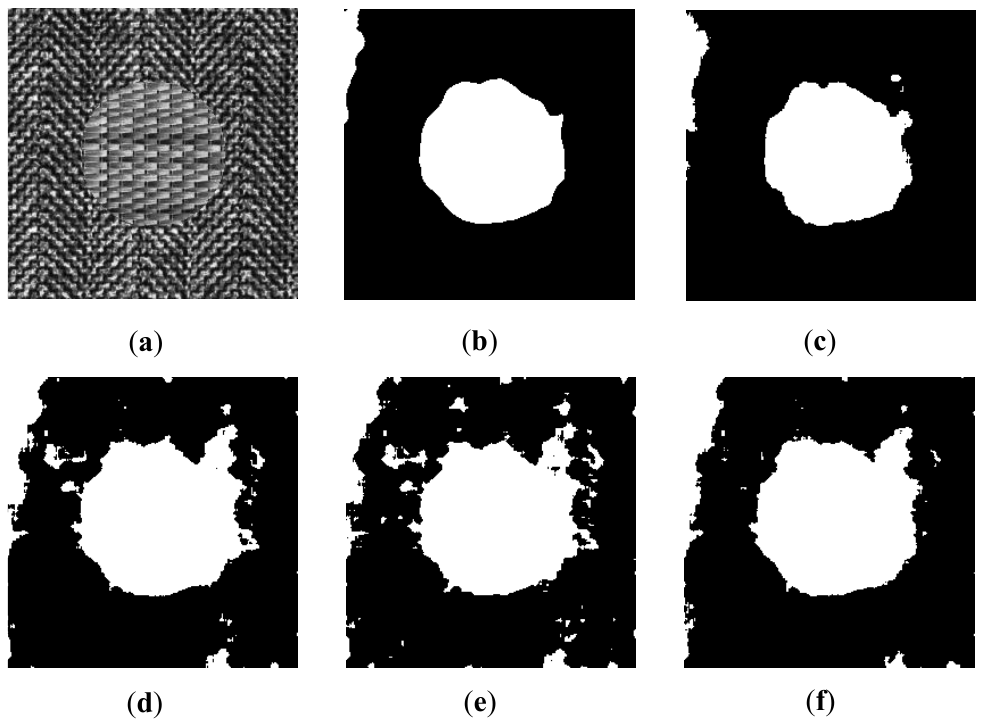
Figure 3. Segmentation results on Image2. ( a ) original image; ( b ) AFWDLMO; ( c )